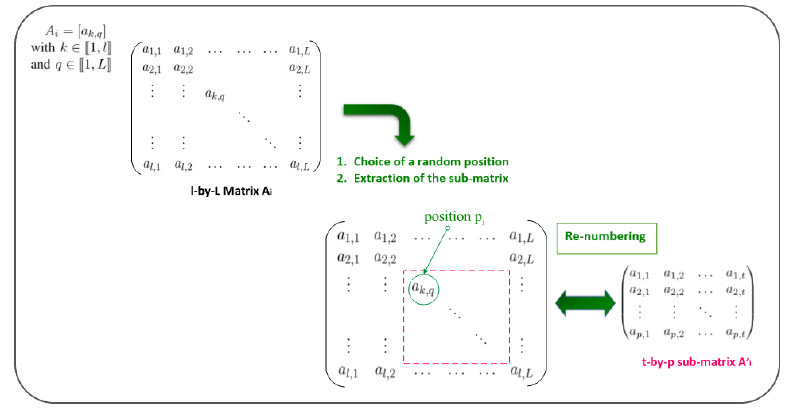
Figure 4. The sub-matrix A (cid:48)